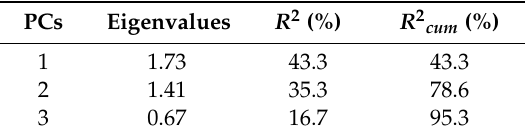
Table 7. Diagnostics of the PCA model on data block [ X 3 , Y ].